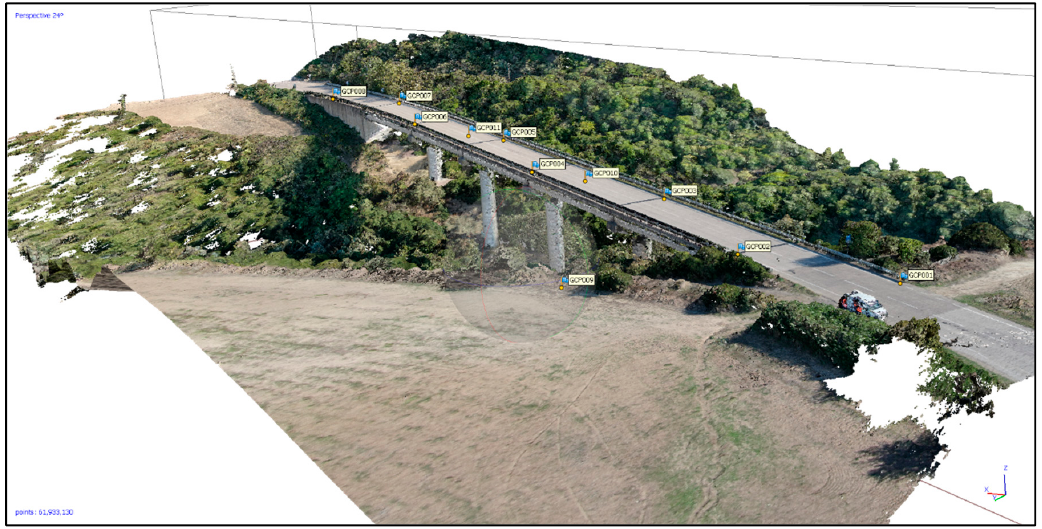
Figure 7. View of the obtained dense point cloud and GCPs/ICPs placement along the structure. Table 2. Final Accuracies recorded in Ground Control Points (GCPs) and Independent Check